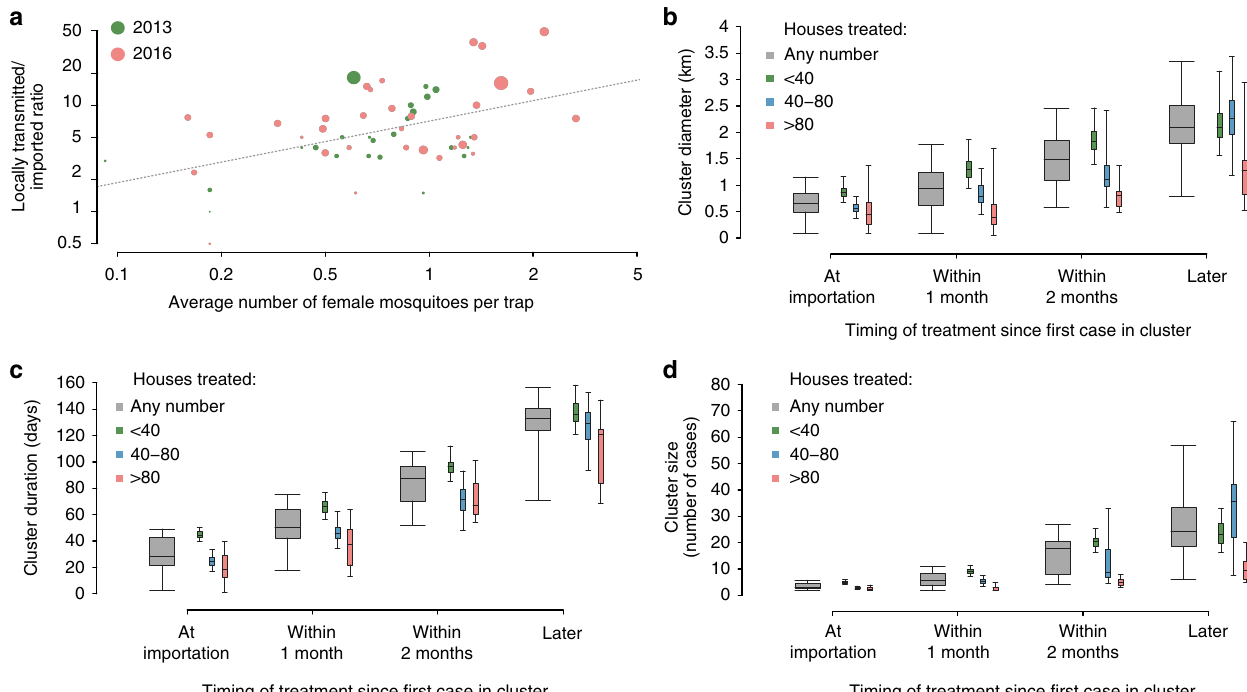
Fig. 5 Effect of mosquito abundance and treatments. a Relationship between transmission intensity, represented by the ratio of local to imported cases, and the neighborhood ’ s mosquito infestation level (log-log scale). Circles: neighborhoods for which the information on mosquito abundance was available (size is proportional to the total number of cases). Dashed gray line: linear regression on the log-transformed variables ( p -value = 0.0001; R 2 = 0.26). b – d Impact of timing and intensity of vector-control on cluster diameter ( b ), duration ( c ) and size ( d ). Center: mean; bounds of box: interquartile range;